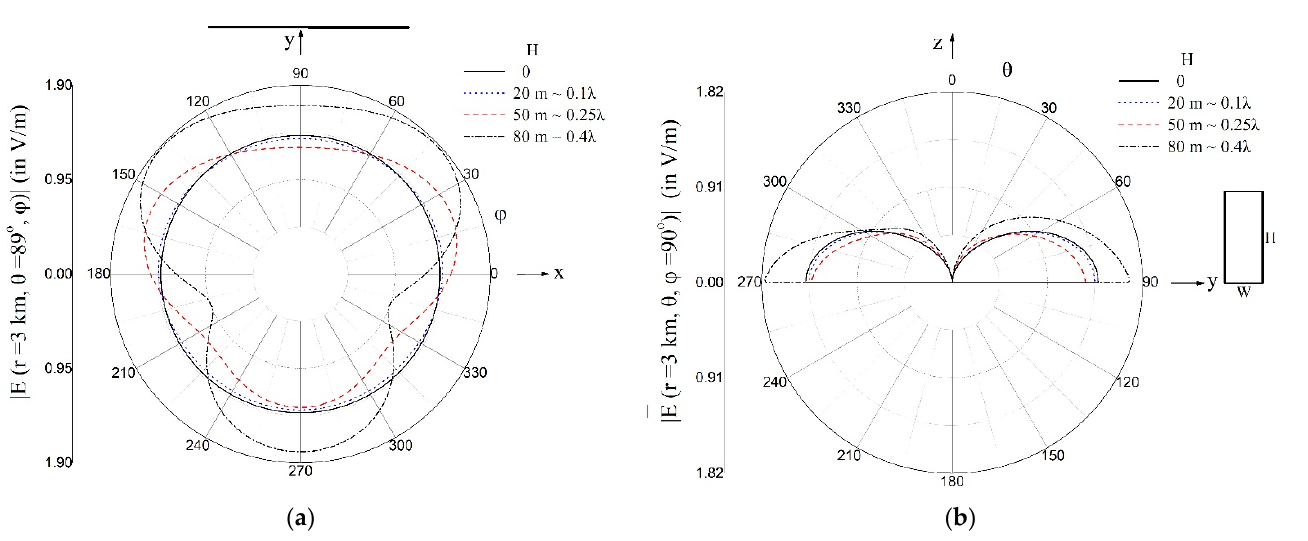
Figure 6. Radiation patterns of the monopole in free space (black, solid curve) and in the presence of a building with 𝐿 = 60 m ≈ 0.3𝜆 and 𝑊 = 10 m ≈ 0.05𝜆 . Three different heights H are considered (dashed and dotted curves, as indicated at the upper right corner). The distance between the antenna and the building is 𝑅 = 100 m ≈ 0.5𝜆 . ( a ) 𝜑 -plane and ( b ) 𝜃 -plane.